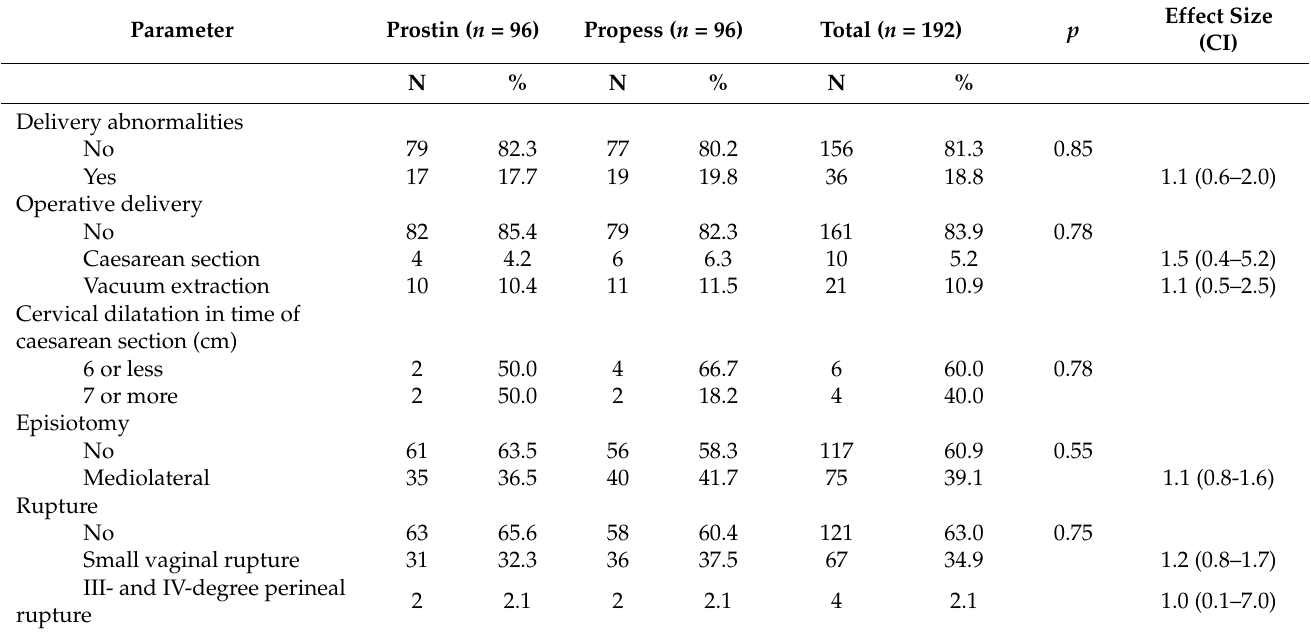
Table 4. Delivery abnormalities data of the study population according to the study groups. N— number of cases, %—percentage of the group, CI—confidence interval.